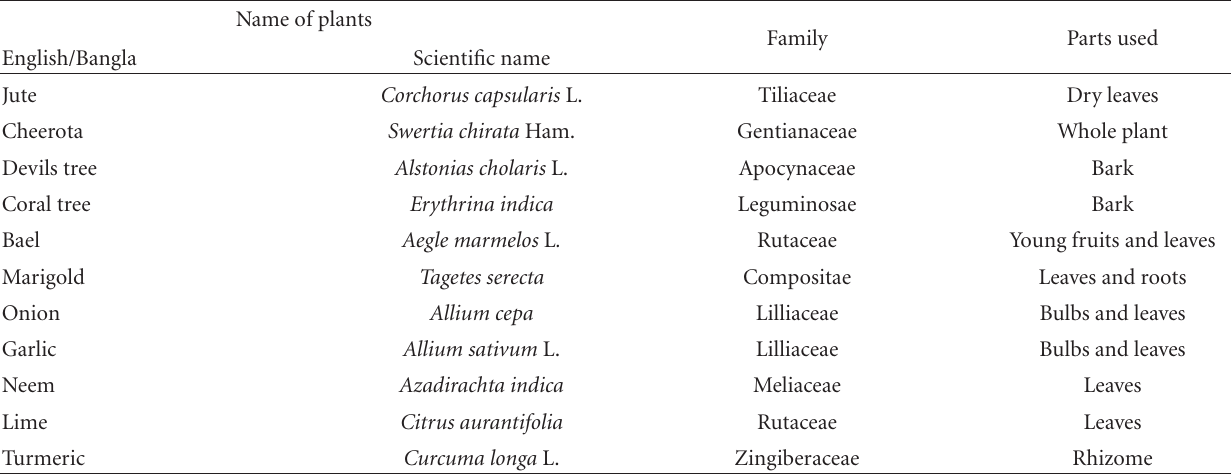
Table 1: List of plants tested to control bacterial soft rot pathogens of